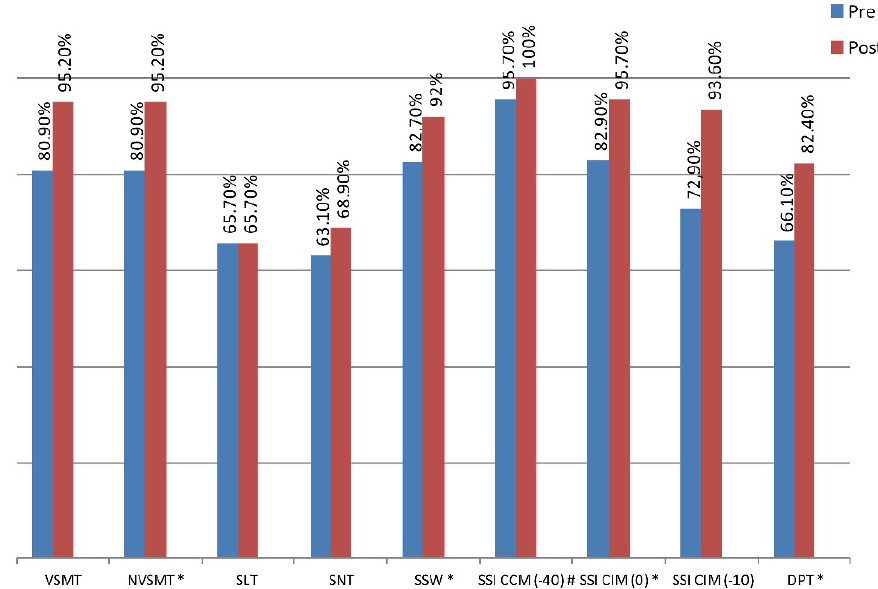
Figure 1 - Mean performance of individuals on behavioral evaluations of auditory processing before and after auditory training. Verbal sequential memory test (VSMT), Non-verbal sequential memory test (NVSMT), Sound location test (SLT), Speech-in-noise test (SNT), Staggered spondaic word (SSW) test, Synthetic sentence identification with competitive ipsilateral (SSI-ICM) and contralateral (SSI- CCM) competitive messages, Duration pattern test (DPT). Statistically significant (*); tending toward significance ( # ).